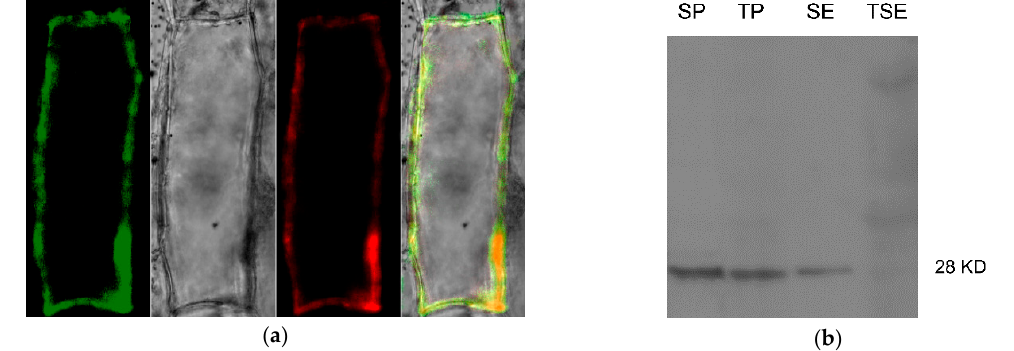
Figure 6. Zm-INVINH4 is targeted in the apoplast. ( a )Transient expression of Zm-INVINH4::GFP